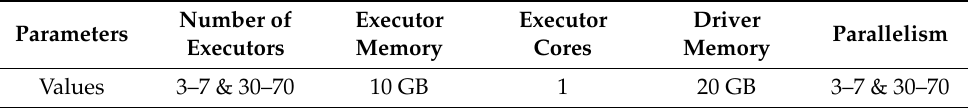
Table 3. Parameters for the Spark submit